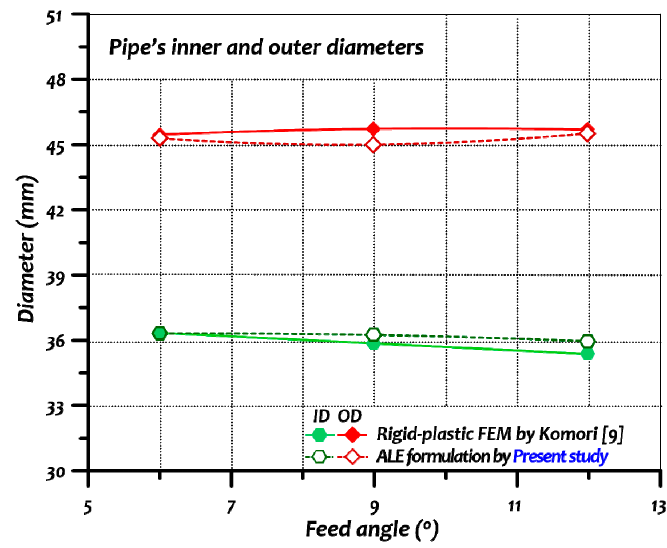
Figure 14. Pipe average diameter versus maximum plug diameter (Note: ALE = arbitrary Lagrangian– Eulerian, ID = inner diameter, OD = outer diameter).